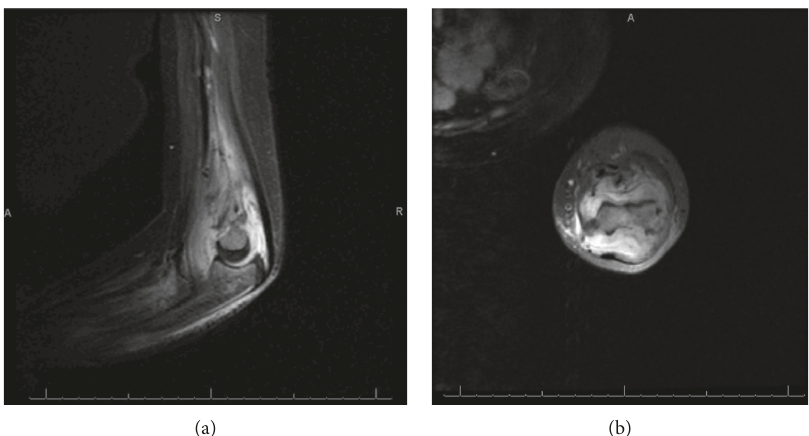
Figure 2: IR sagittal MRI of the left elbow showing a large loculated joint effusion with tracking up the posterior aspect of the humerus (a). T2 fat-suppressed axial MRI of the left distal humerus showing joint effusion